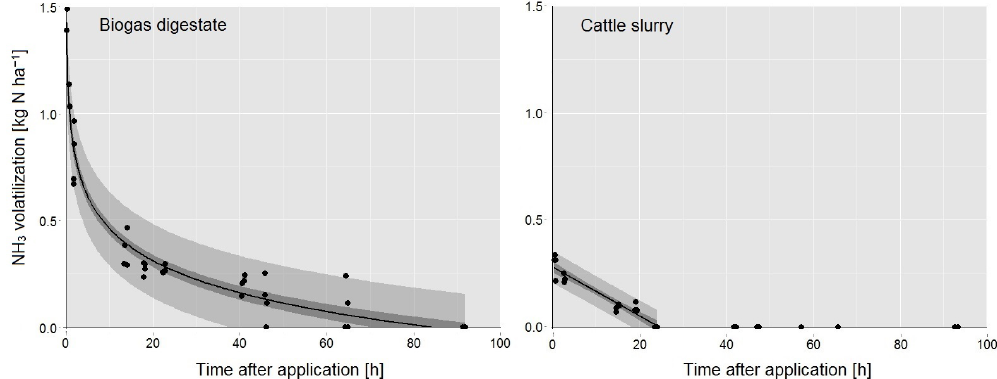
Figure 7. Ammonia (NH 3 ) volatilization following organic fertilizer application at event 3 (27 May 2011). Dots present single NH 3 measure- ments for a time period of 94h. Black lines show the estimated NH 3 volatilization with 95% confidence band (dark gray) and 95% prediction band (light gray). The model function for biogas digestate is y =− 0.2619 ( ± 0.025) · ln( x ) + 0.9605 ( ± 0.008); r 2 = 0.96; P < 0.0001; the